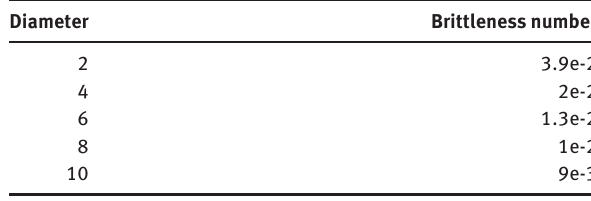
laminates open hole. s